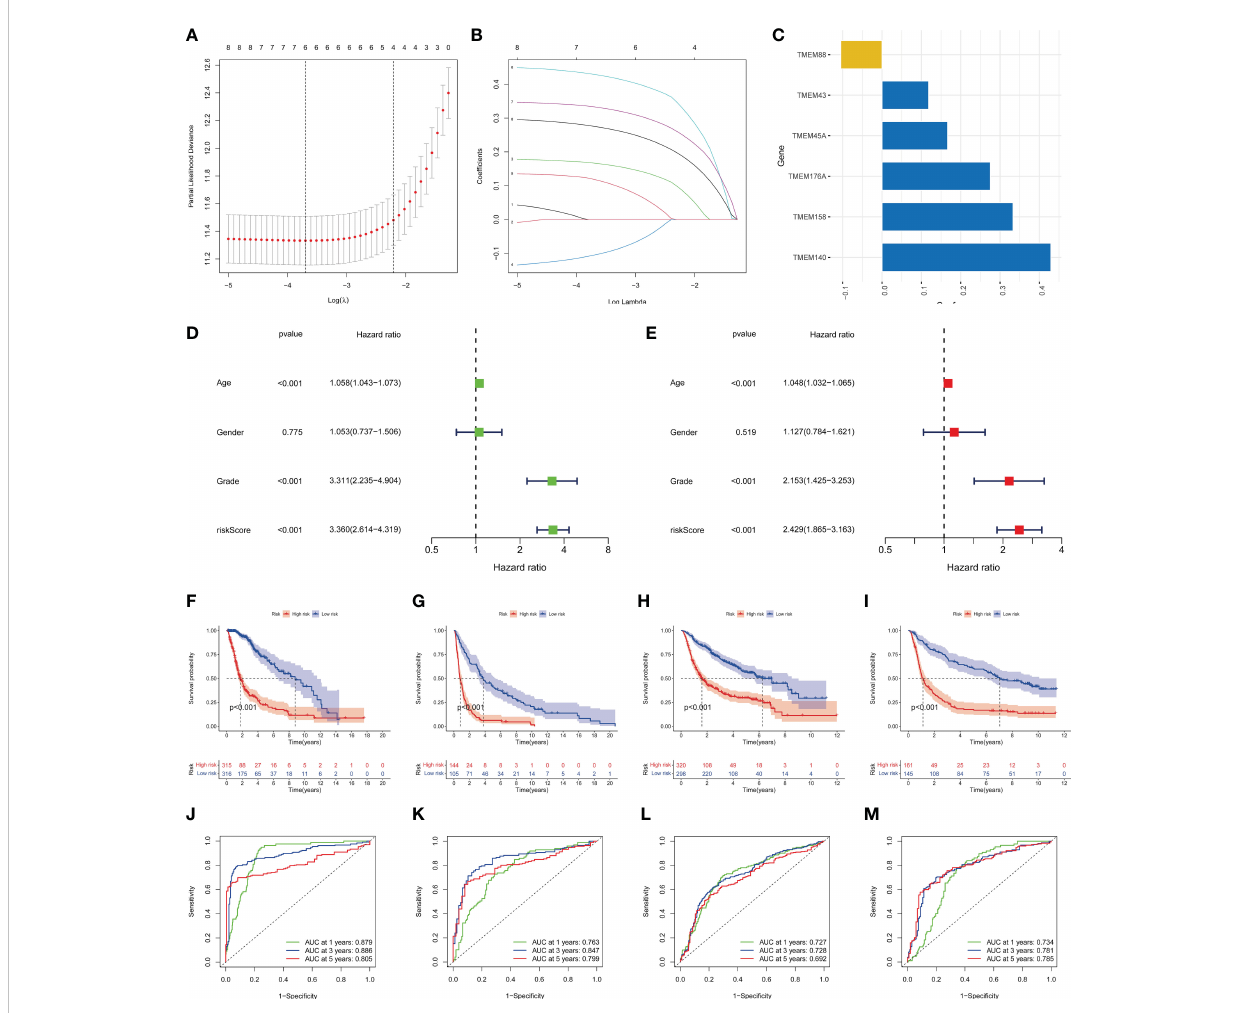
FIGURE 4 Identi fi cation of the transmembrane protein prognostic signature. (A, B) LASSO Cox regression analysis of the 9 OS-related transmembrane proteins. (C) The 6 genes included in the signature. Corresponding coef fi cients were depicted by horizontal bars, respectively. (D, E) Univariate and multivariate Cox regression revealed signi fi cant survival-related clinicopathological parameters in the forest plots diagram. (F-I) Kaplan – Meier OS curves with difference detection by log-rank test for patients from the training and validation datasets. TCGA-glioma, GSE16011, CGGA693, and CGGA325 datasets are arranged from left to right. (J-M) ROC analysis of the 6-genes signature in the four